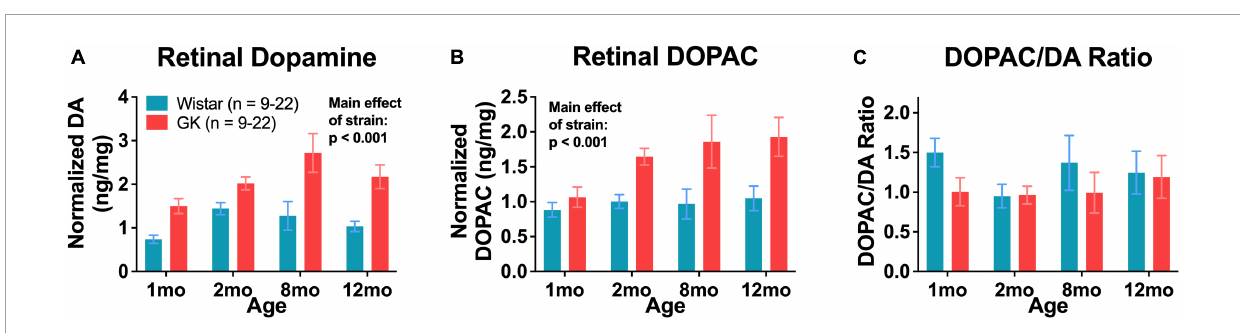
FIGURE7 Goto-Kakizaki rats have endogenously high levels of retinal dopamine and DOPAC. Retinal dopamine (A) and DOPAC (B) levels in GK rats and Wistar controls. (C) DOPAC/DA ratio in GK rats and Wistar controls. Results expressed as mean ±